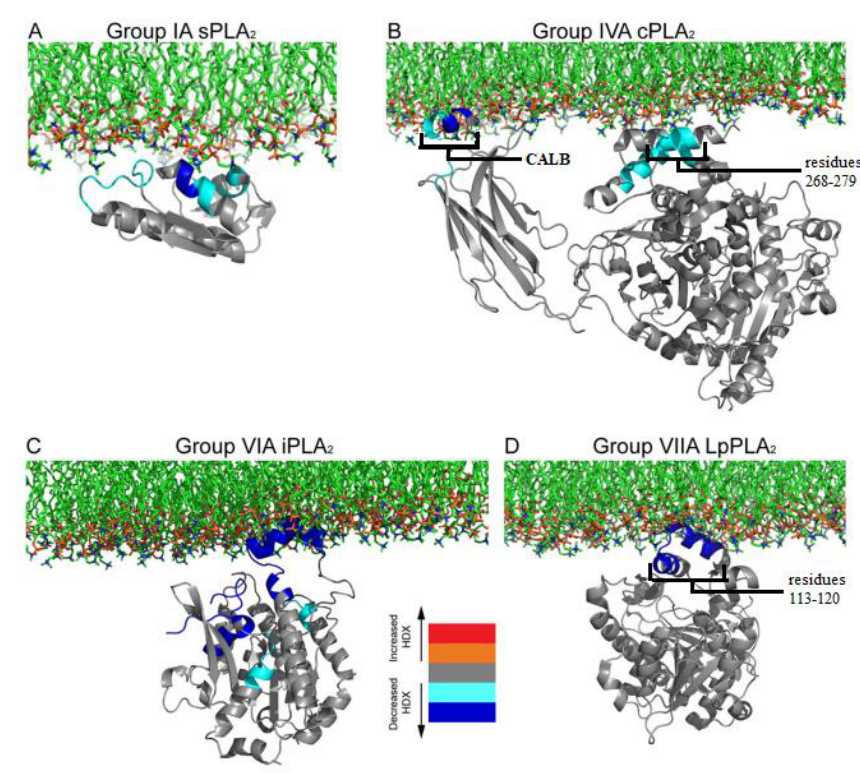
Figure 15. Proposed schematic models of interfacial binding of four different families of PLA2s. HDX-MS technique was used to study the interaction of monomers of different PLA2s bound to membranes, using crystal structures of ( A ) group IA sPLA2 (PDB- 1PSH), ( B ) group IV cPLA2 (PDB- 1CJY), ( C ) group VIA iPLA2 (homology model based on lipase patatin structure, PDB- 1OXW) and ( D ) group VIIA Lp-PLA2 (PBD- 3D5E). Reprinted from